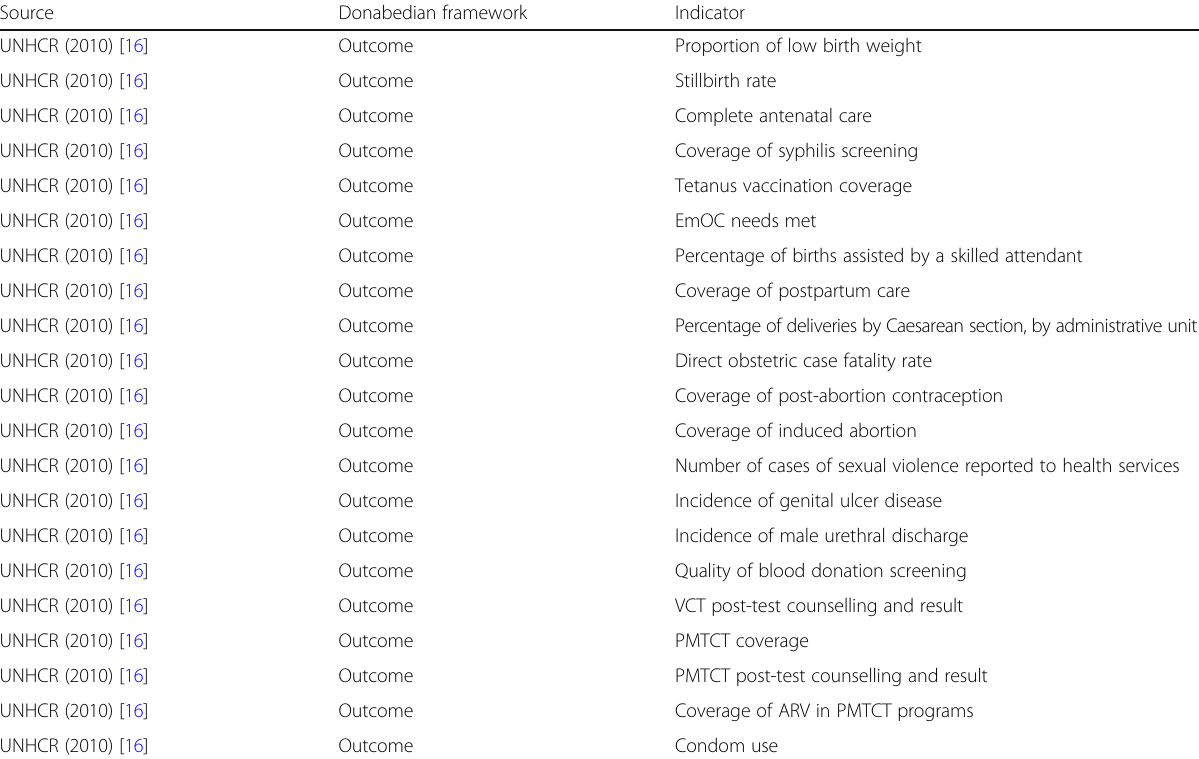
Table 2 Indicators of the topic reproductive health (Continued)